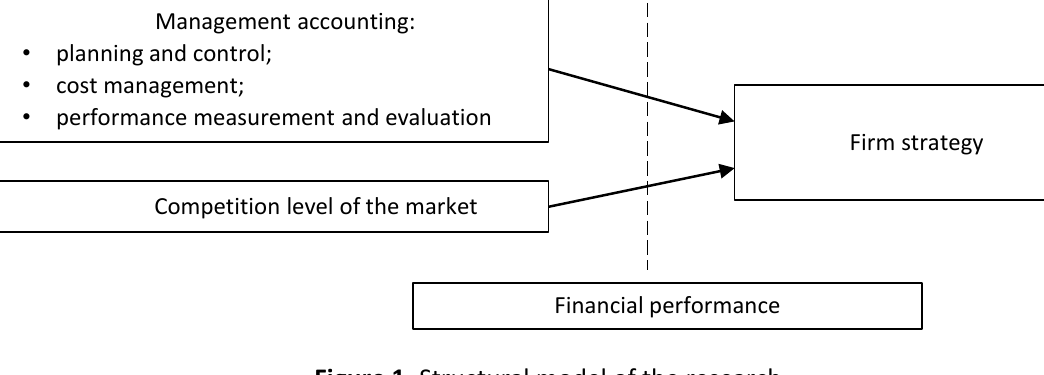
Figure 1. Structural model of the